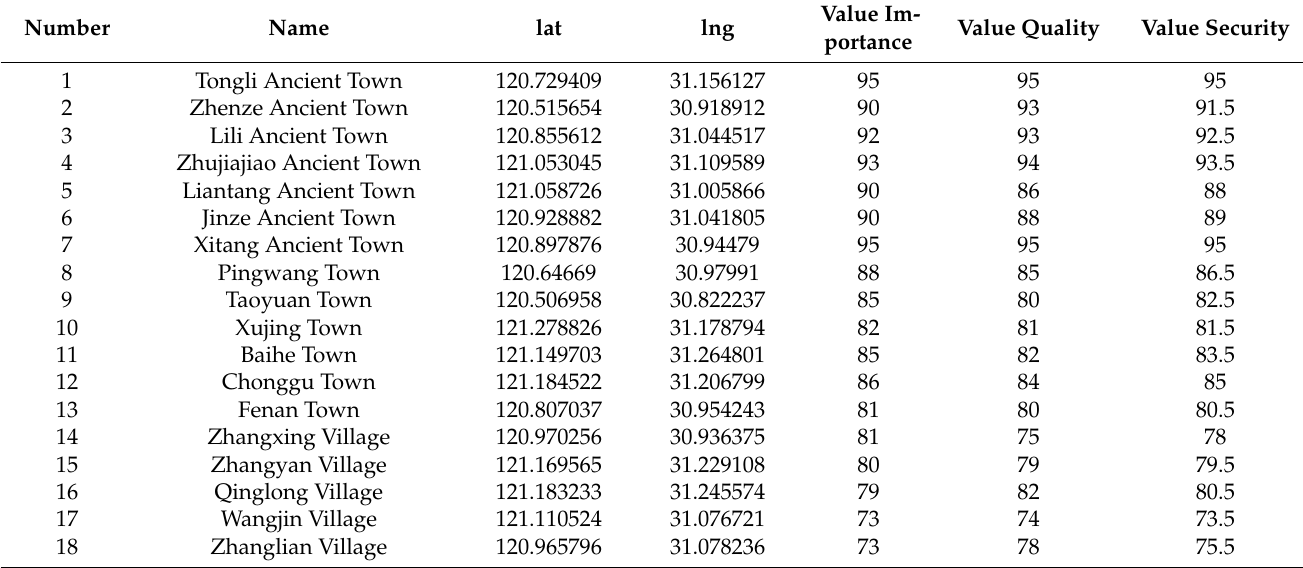
Table A1. The cultural value security score of each value attribute